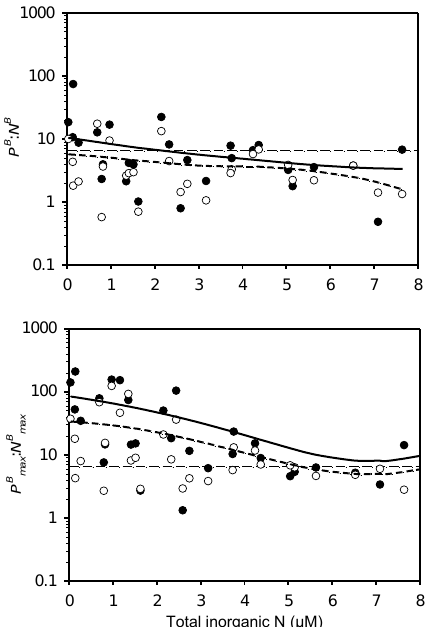
Fig. 10. Relationships between total inorganic N and C:N up- take ratios under trace (closed symbols) and enriched (open sym- bols) N additions at E SCM (upper panel) and under saturating light conditions (bottom panel). Lines indicate the Redfield ratio (thin dashes) and moving averages for trace (solid) and enriched (dashes) conditions.